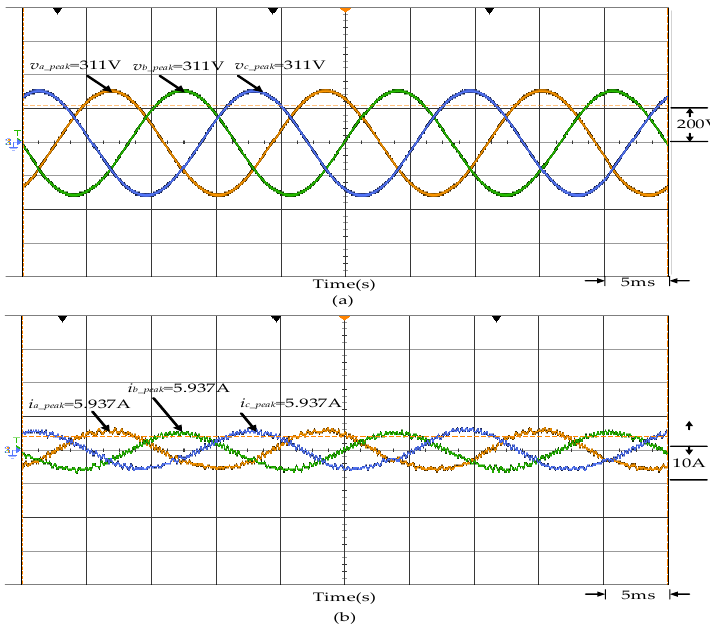
Figure 17. The three waveforms under the actual test of the smart three-phase inverter: ( a ) output voltage waveforms; ( b ) output current waveforms.